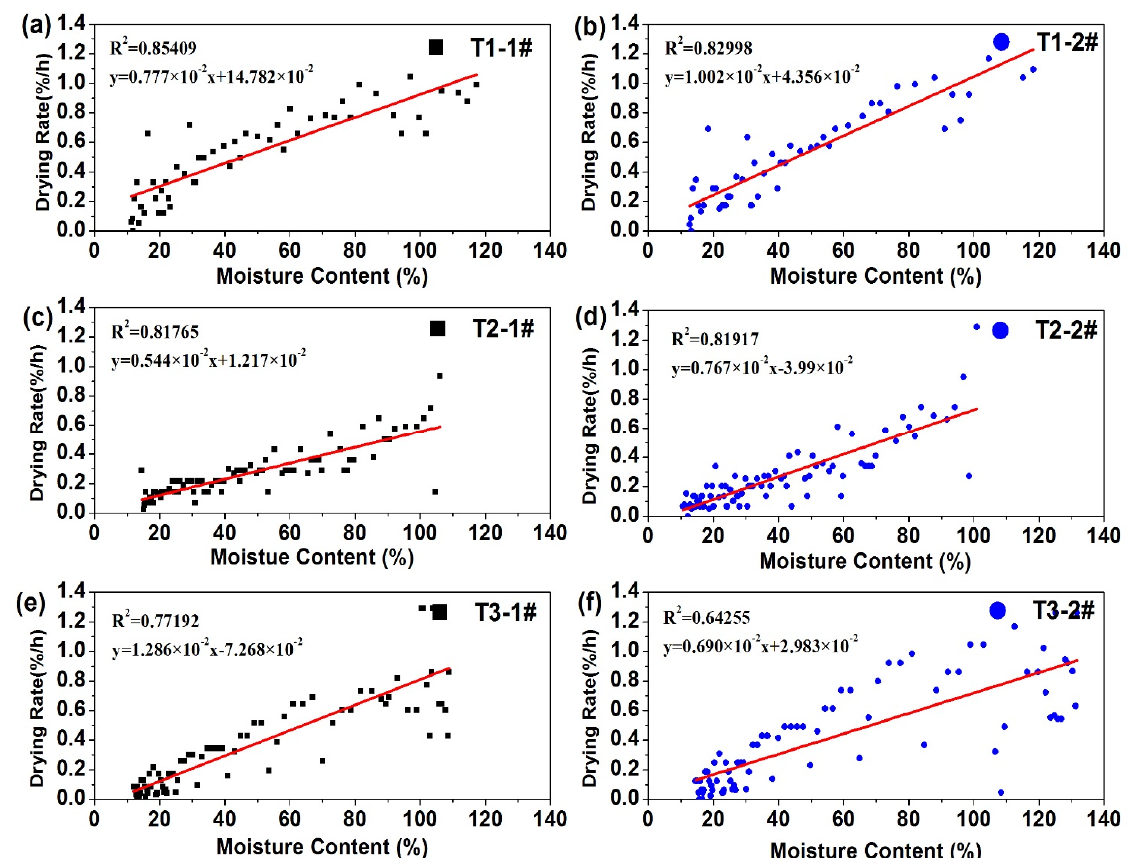
Figure 4. Curves depicting changes in the drying rates of T1, T2, and T3 during wood drying. 1# and 2# drying rate curves of T1 ( a ), ( b ); 1# and 2# drying rate curves of T2 ( c ), ( d ); 1# and 2# drying rate curves of T3 ( e ), ( f ). Table 2. Final moisture content after